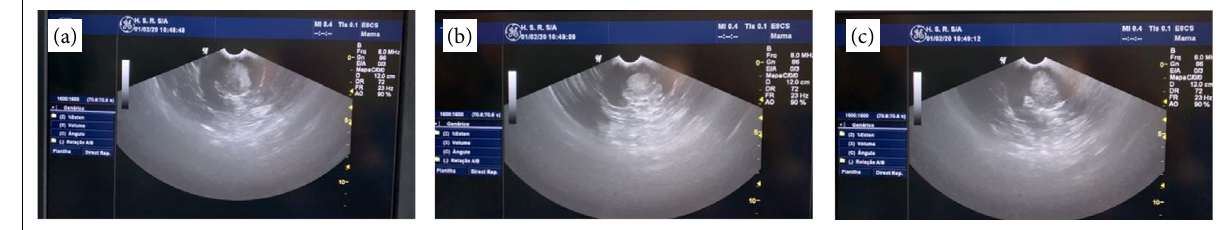
Figure 3 - Endocavitary probe image projected onto the ultrasound cart screen with visualization of the renal endophytic